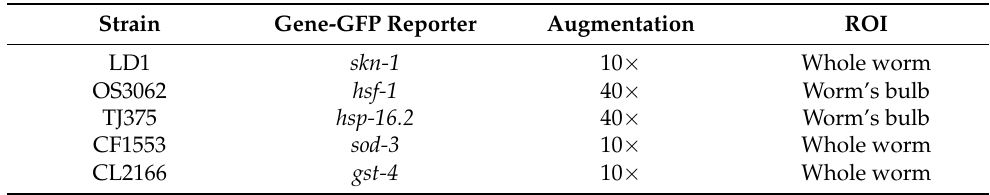
Table 1. Compartment location studied in the specific GFP reporter